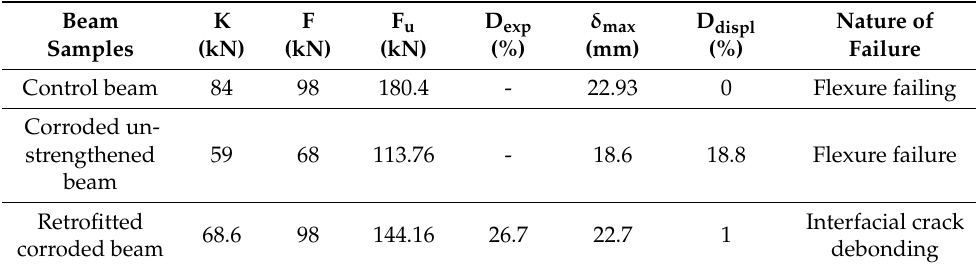
Table 2. Comparisons between maximum load and